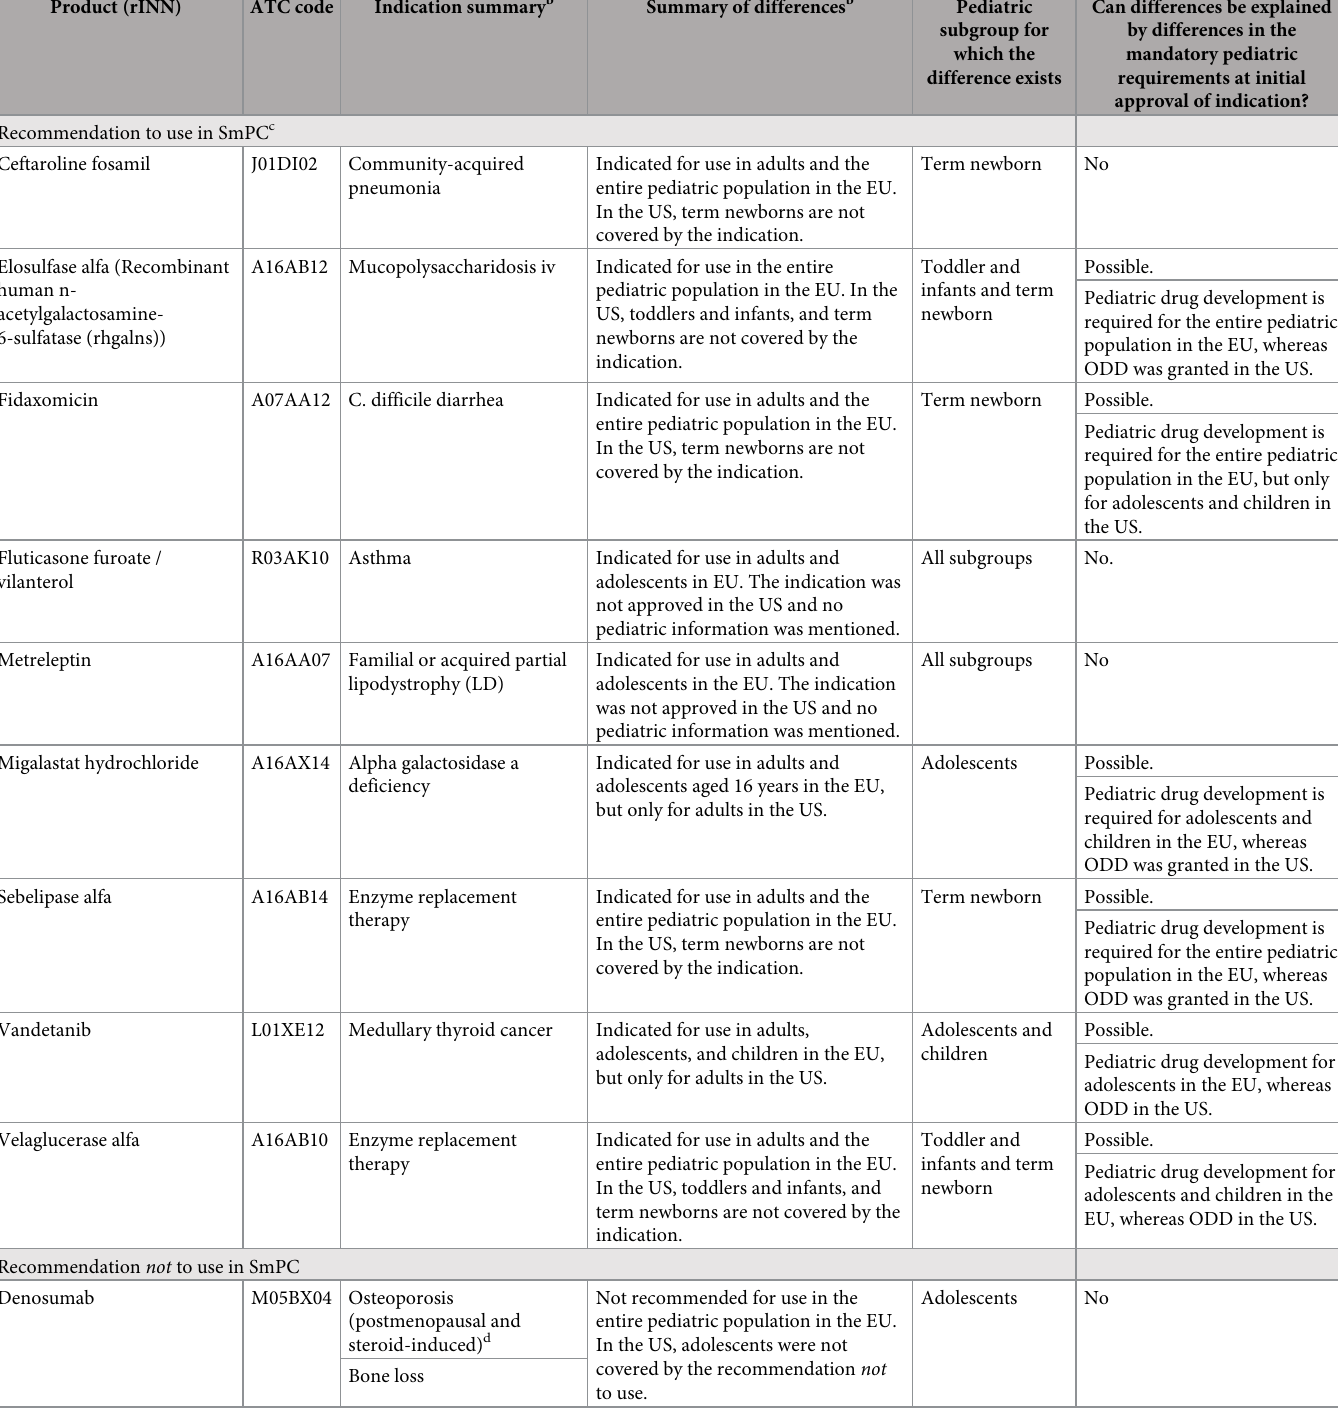
Table 7. Summary of discrepancies in the guidance for pediatric use for indications where SmPC provides more guidance than USPI a ( n = 31). Ordered by the guid- ance for pediatric use in the EU in which the difference exists and alphabetically by active substances